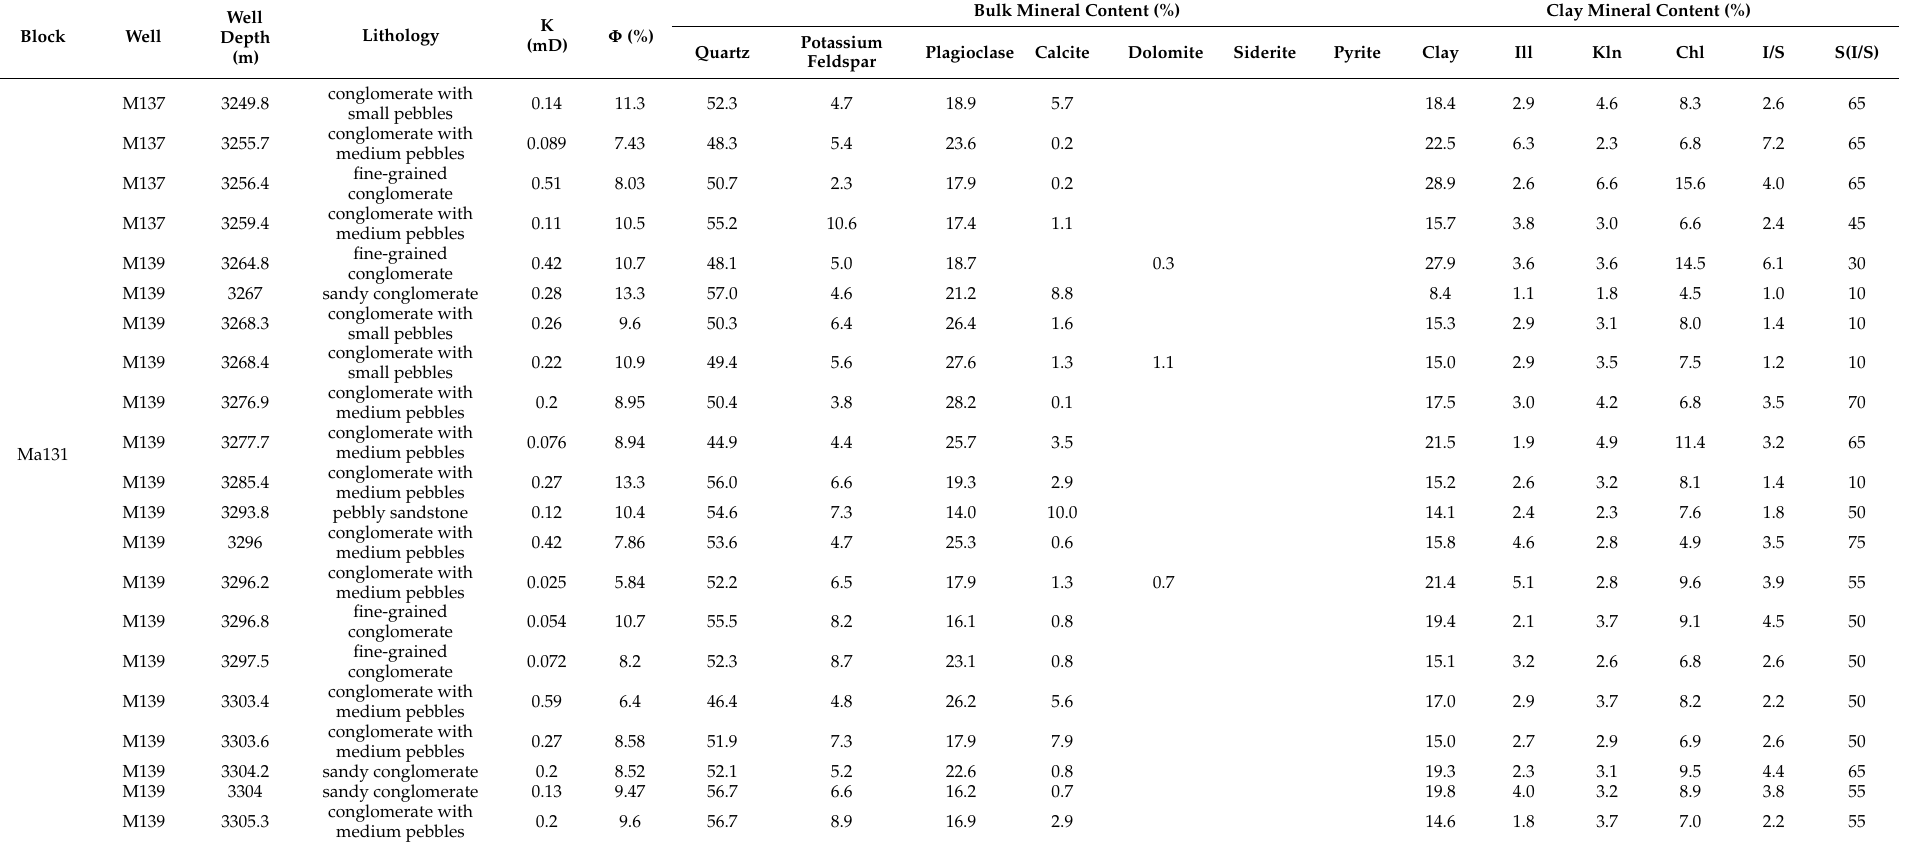
Table 1. Bulk and clay mineral analysis results for samples from the Mahu